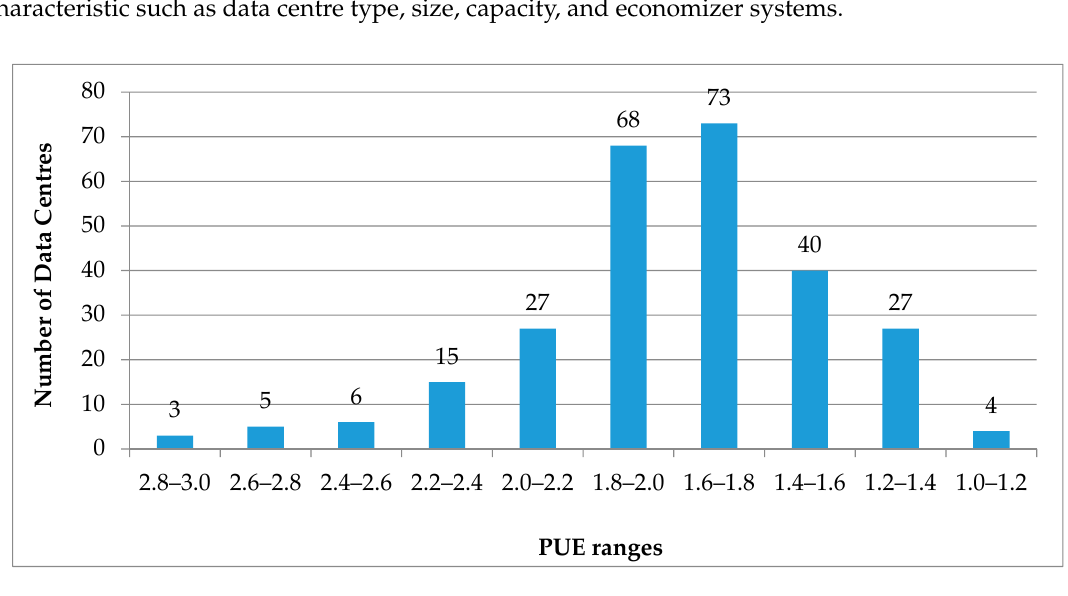
Figure 2. Number of Data Centres per Power Usage Effectiveness (PUE) range.